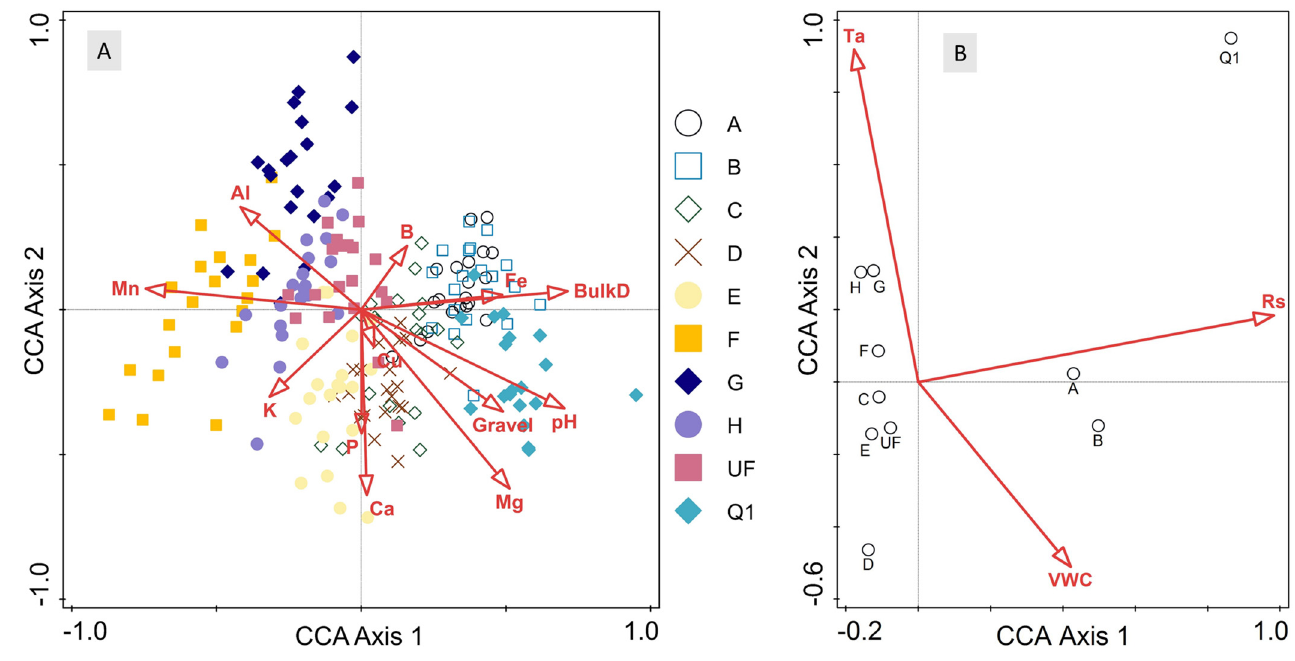
Figure 5. Canonical Correspondence Analysis (CCA) ordination diagrams (biplots) showing delin- eation of quadrats ( A ) and plots ( B ) based on plant species composition as explained by environmental variables in eight plots (A–H) within the 70-year-old abandoned quarry (Q70) and in the reference plots at an urban forest (UF) and a recently decommissioned quarry (Q1) in Jefferson City, Missouri, USA. Symbols in (a) show the 200 quadrats in which soil variables were measured; in (b) quadrat-level species data had been averaged to the plot-level to match the scale of microclimate measurements. The arrows point toward the direction of the steepest increase of values of environmental variables; the coordinates of an arrow tip are correlations of the environmental variable with the two ordination axes (e.g., bulk density is highly correlated with Axis 1, but there is almost no correlation with Axis 2). UF separates from the other sites along the 4th ordination axis (Figure A1).